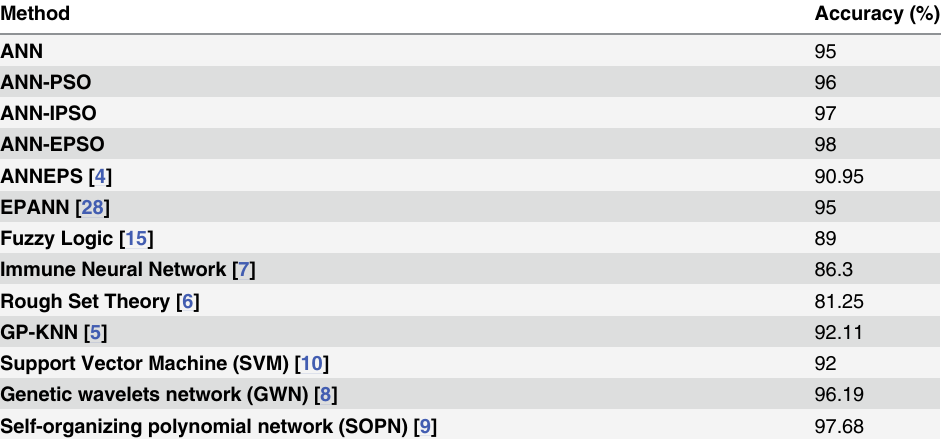
Table 9. Comparison of the proposed methods with previous